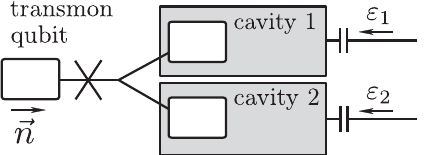
FIG. 4. Sketch of a two-cavity configuration with a dispersively coupled common transmon qubit [43], which is sufficient for realizing the two-mode codes. Each of the elements has a separate drive, denoted by ε j and ~n , respectively. Alternatively, one could use two distinct modes of the same